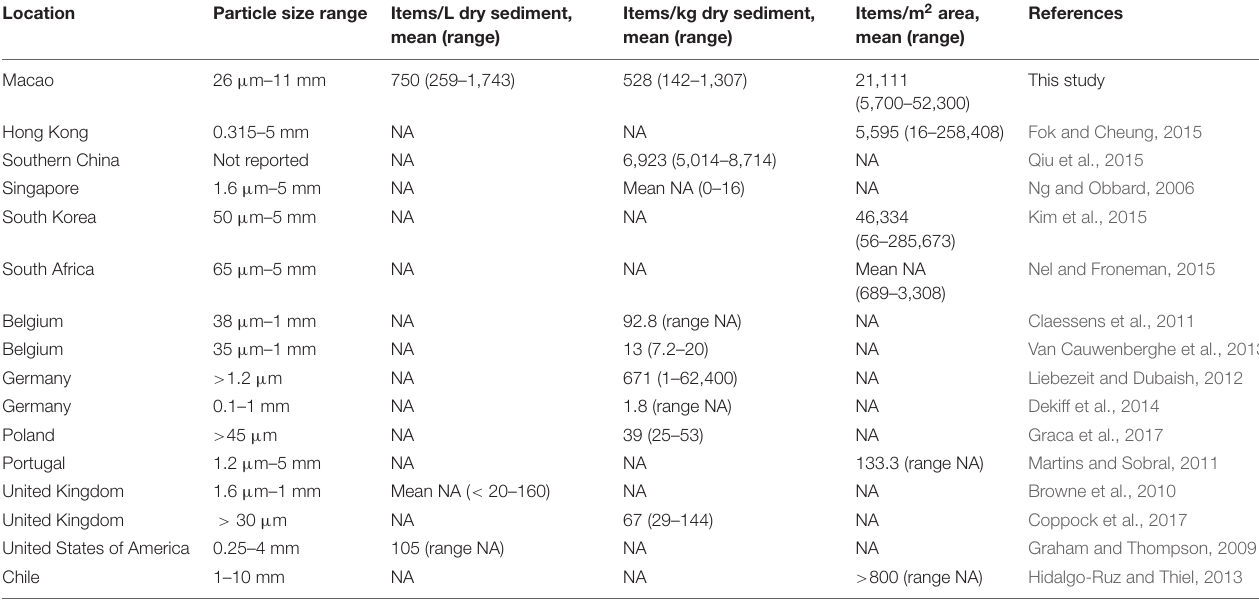
TABLE 6 | Abundance of microplastics in sediment collected from Macao and other areas in Asia, Europe, America, and Africa.